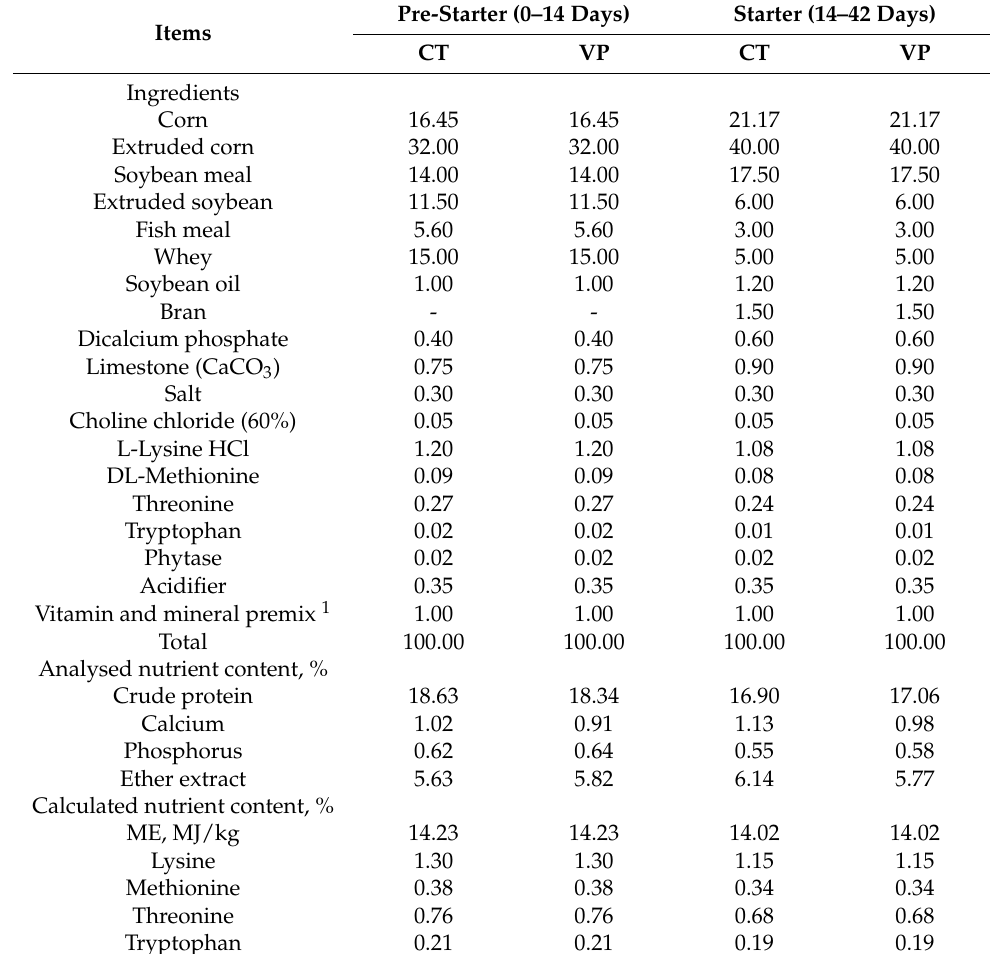
Table 1. Ingredient and calculated nutrient composition of the basal diet (as fed basis,